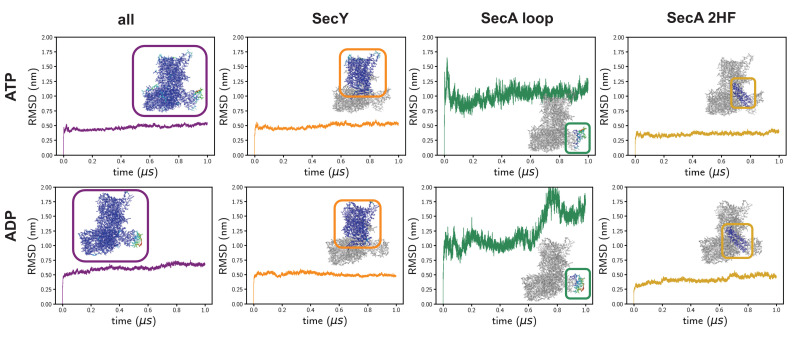
Time-evolving root-mean-squared displacements (RMSD) from the input coordinates.On the left is the RMSD of all of the Cα atoms, which is the standard RMSD analysis. In these simulations, the RMSD is reasonably high, presumably as a result of the high degree of structural remodelling required. Root-mean-squared-fluctuation analyses reveal a very high degree of fluctuation in a specific SecA loop (green data), which affects the global analysis. The RMSDs of SecY alone – which is the region of interest in this study – are much lower and more stable (orange). The SecA 2HF is also highly stable (gold).